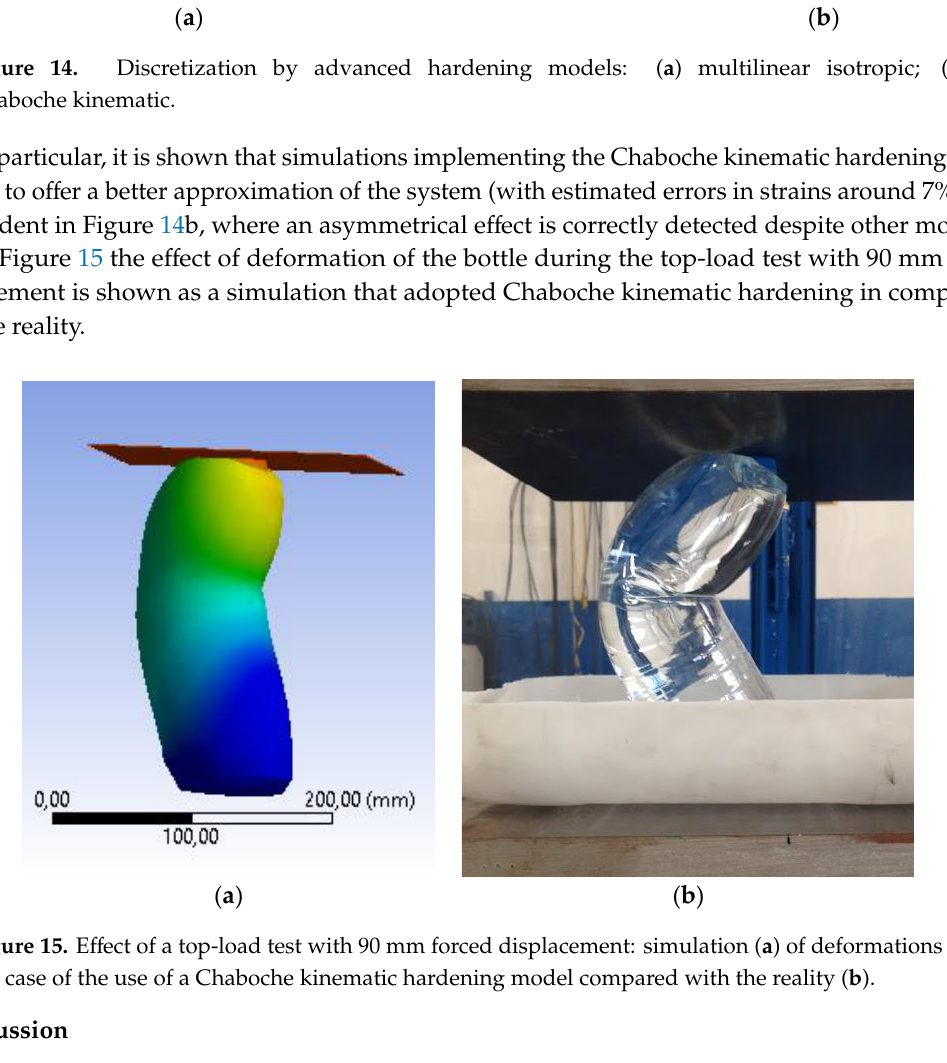
the case of the use of a Chaboche kinematic hardening model compared with the reality ( b ).